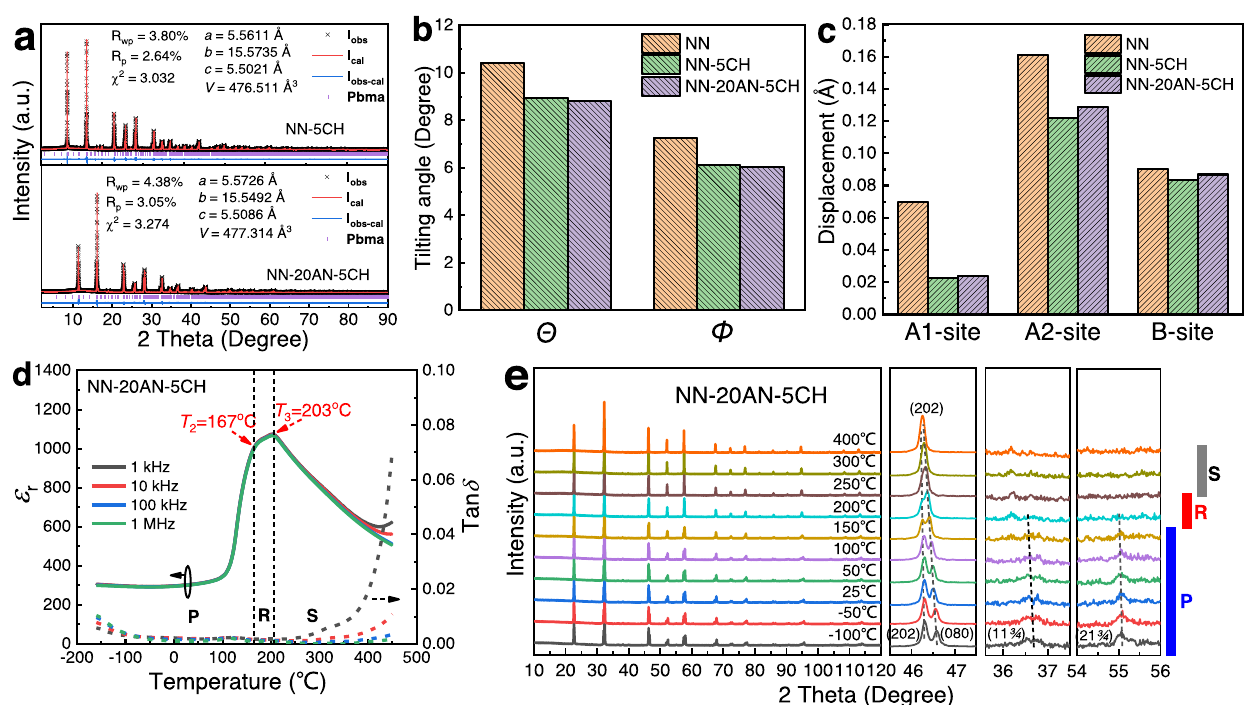
Fig. 2 | SXRD, dielectric properties and temperature dependent XRD. a Retrievedre fi nementplotsofSXRDforNN-5CHandNN-20AN-5CH.Acomparison studyof( b )the[BO 6 ]octahedraltiltingangles Θ and Φ ,and( c